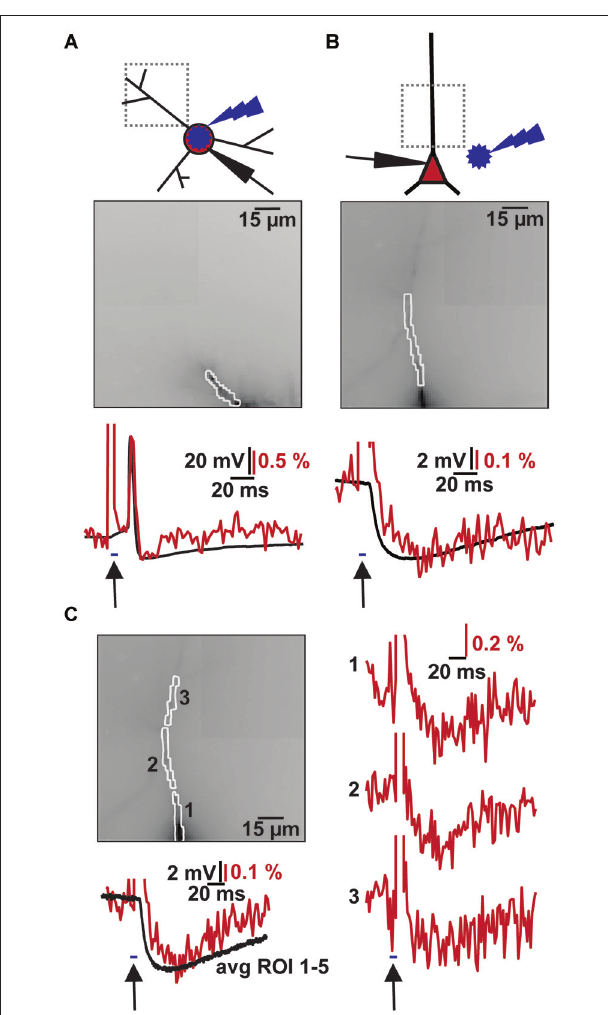
FIGURE 3 | Combined VSD recording with ChR2 activation. (A) Imaging of light evoked AP in ChR2+ interneuron. Top: Schematic illustration of patched ChR2+ interneuron, site of blue flash and imaging region. Middle: Image of filled dendrite with highlighted region of interest ( (cid:80) = 54 pixel). Bottom: Simultaneous optical dendritic (red trace, DF/F = 2.1%, average of 2 trials) and electrical somatic (black trace, ∆ V = 73.4 mV; Vm = − 40 mV) recording. Arrow indicates blue light application (2 ms). (B) Imaging of induced IPSP in CA1 pyramidal cell. Top: Schematic illustration of patched cell, site of blue flash and imaging region. Middle: Image of filled apical dendrite with highlighted region of interest ( (cid:80) = 34 pixel). Bottom: Simultaneous optical dendritic (red trace, DF/F (IPSP) = 0.4%, average of 10 trials) and electrical somatic (black trace, ∆ V (IPSP) = 4.9 mV; Vm = − 60.1 mV) recording. Arrow indicates blue light application (5 ms). (C) High resolution optical recording after blue light stimulation. Left top: Image of filled apical dendrite with highlighted ROIs (1–3, average of 6 trials). Left bottom: Simultaneous optical dendritic (red trace, (cid:80) = 130 pixels, DF/F (IPSP) = 0.3%) and electrical somatic (black trace, ∆ V (IPSP) = 5.9 mV; Vm = − 59.8 mV) recording. Right: Optical dendritic recordings of evoked IPSP patterns in the marked ROIs. Arrow indicates blue light application (5 ms).